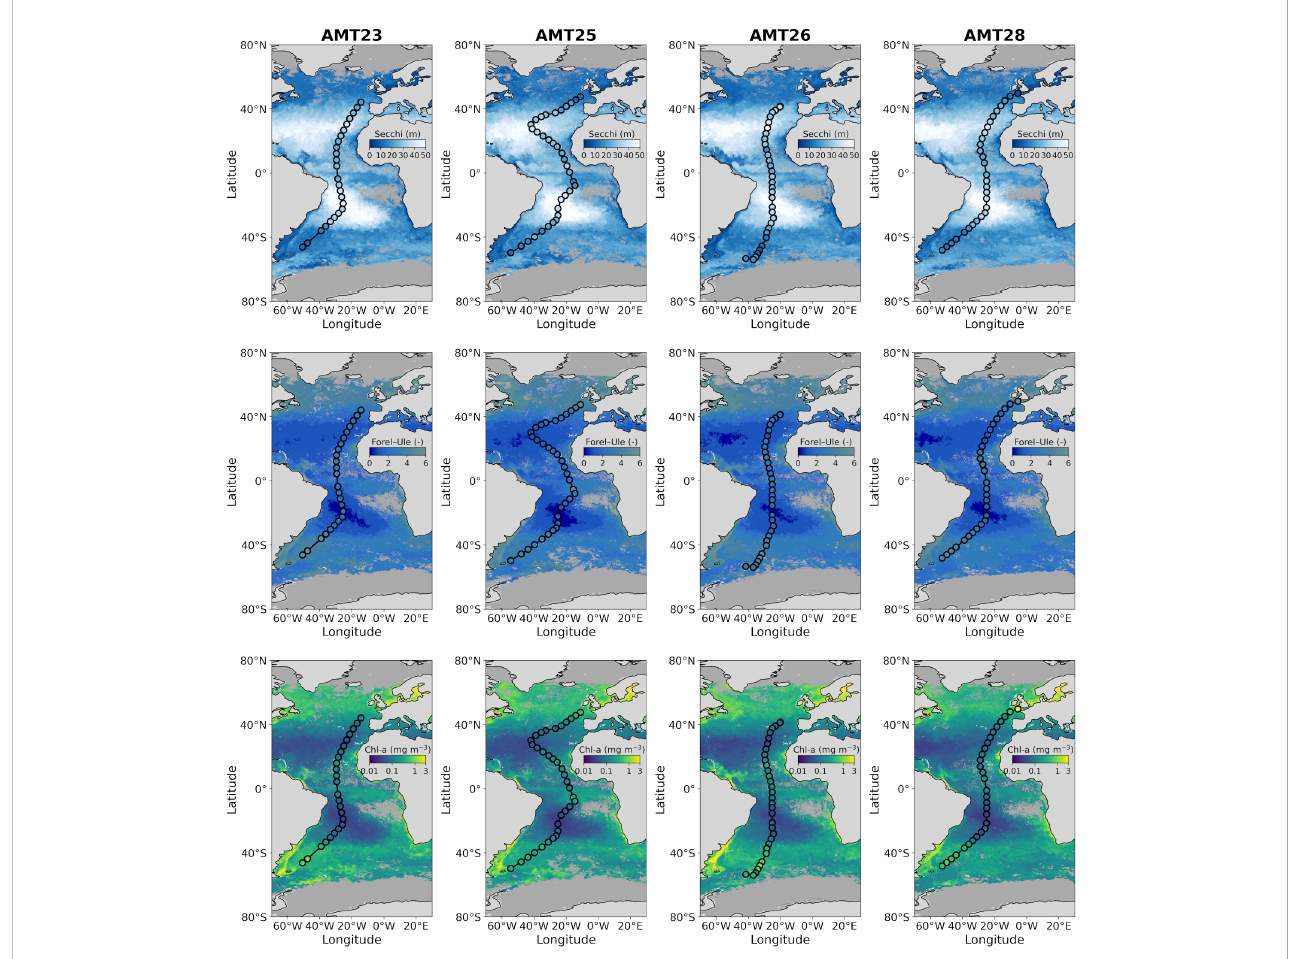
FIGURE 1 Locations of the 127 AMT stations where Secchi depth, Forel-Ule colour (using the LaMotte scale, for the colour of the disk at half the Secchi depth converted to in fi nite colour using the method of Pitarch (2017)) and Chl-a data were collected, on the four AMT cruises. The transects are overlain onto satellite estimates of Secchi depth (Pitarch et al., 2021), Forel-Ule colour (Pitarch et al., 2021), and Chl-a concentration (Sathyendranath et al., 2019), for the month of October (during which the AMT cruises took place), for each of the respective years that the cruises took place (AMT23 October 2013, AMT25 October 2015, AMT26 October 2016, AMT28 October 2018). Satellite data are from version 4.2 of the Ocean Colour Climate Change Initiative (Sathyendranath et al., 2019). The stations are coloured using the in-situ data, using the same colour scale as the satellite data, to illustrate how the two independent estimates of Secchi depth, Forel-Ule colour and Chl-a compare